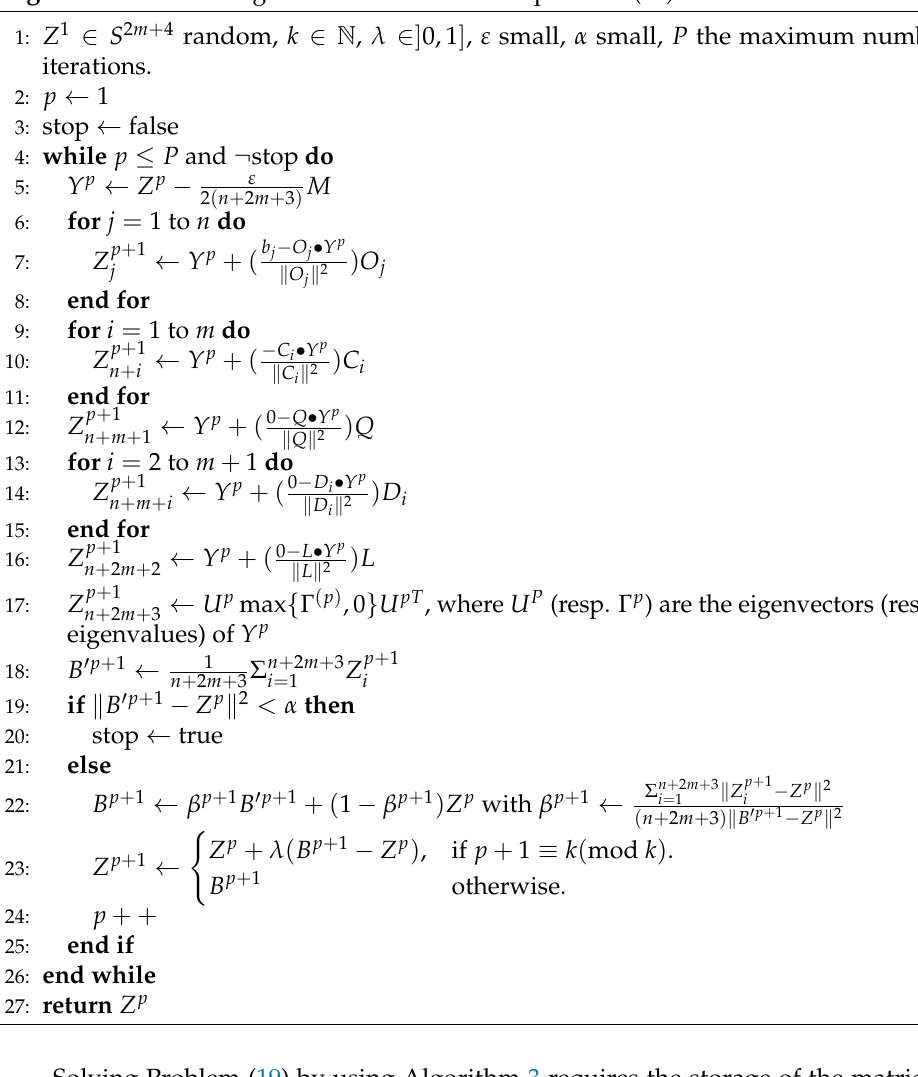
Algorithm 3 Pierra’s algorithm to solve the SDP problem